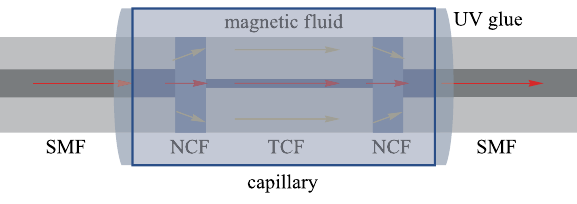
Fig. 6 Magnetic fluid sensor based on the no-core-fiber/thin-core-